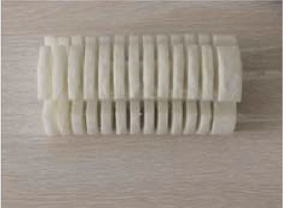
Figure 9: Physical model of pneumatic soft-bodied bionic actuator.